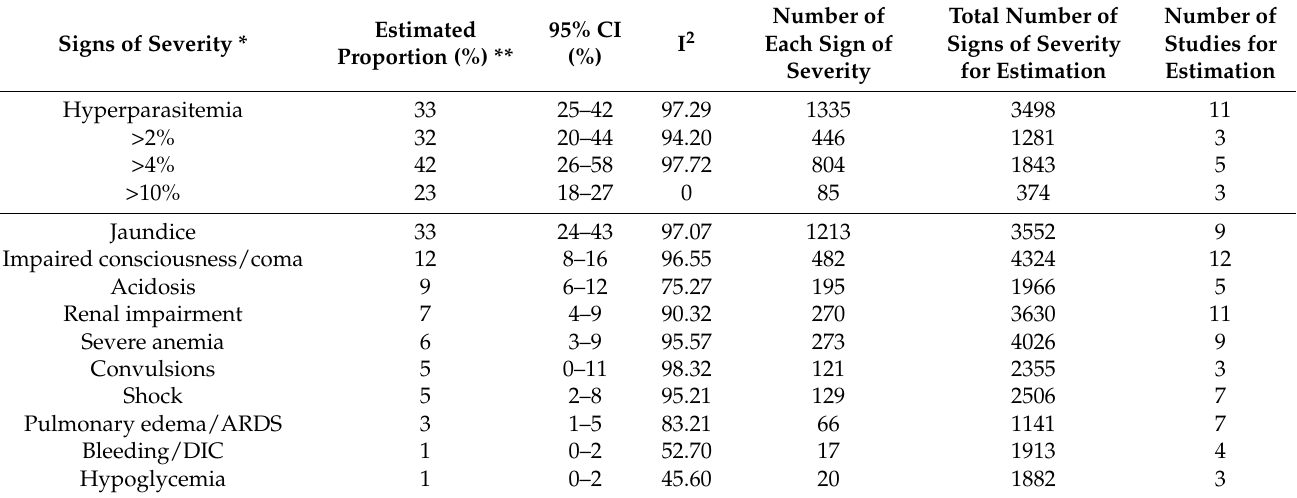
* Signs of severity by guidelines for the treatment of malaria 2015, and WHO Guidelines for malaria 2021, except for hyperparasitemia >2% and >4% (adapted guidelines). ** The proportion was estimated by the random- effects